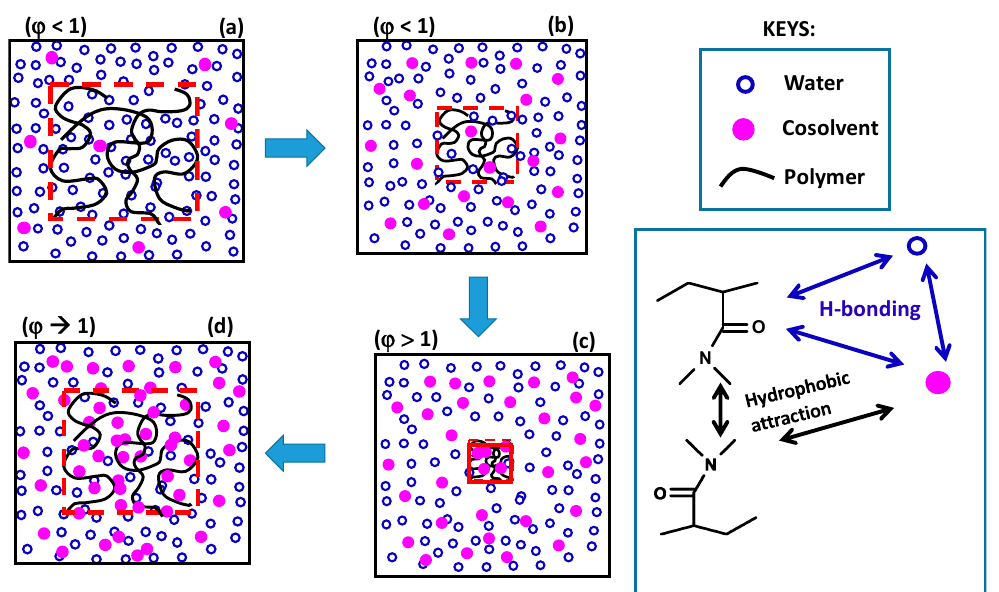
Figure 9. Schematic illustration of re-entrant volume phase transition in hydrogels ( a – d ). The double arrows indicate intermolecular